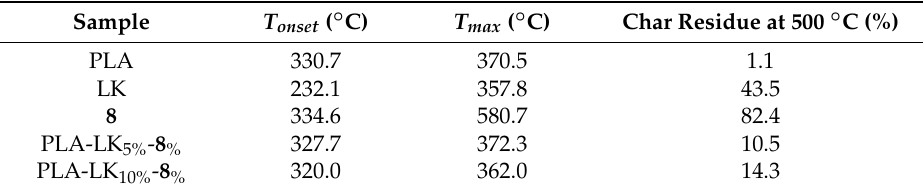
Table 11. Thermal properties of PLA composites.